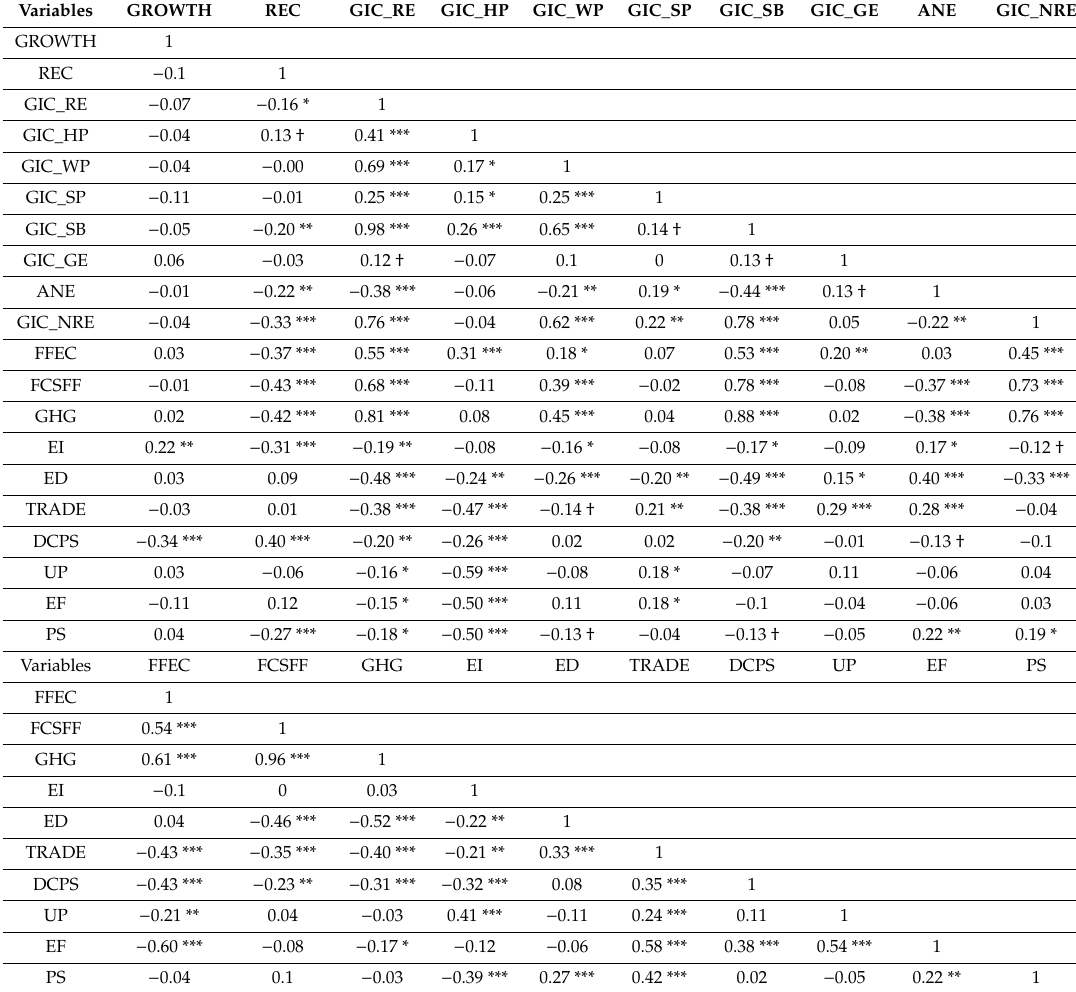
Table 4. Correlation